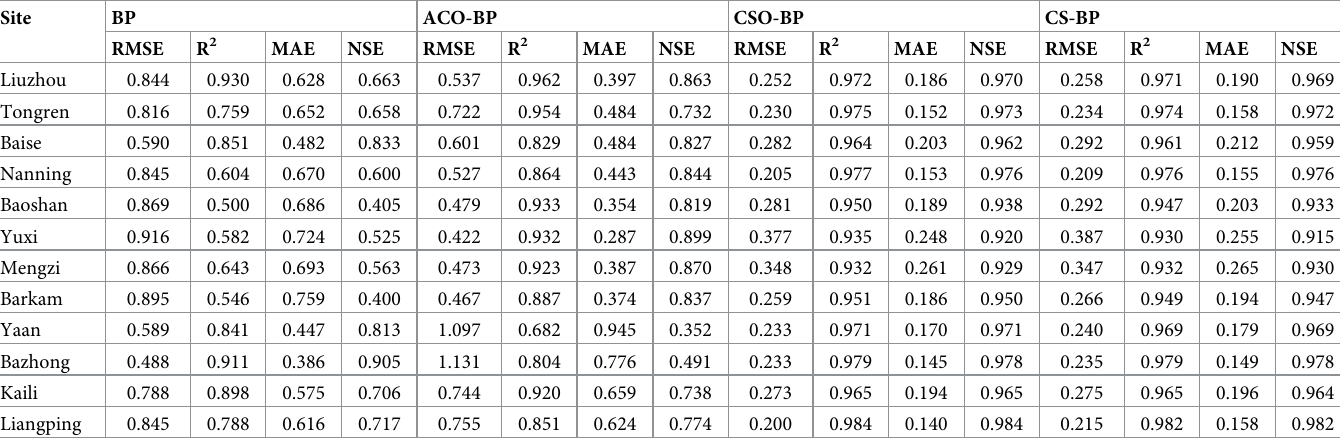
Table 1. Accuracy indicators of the four ET O models.